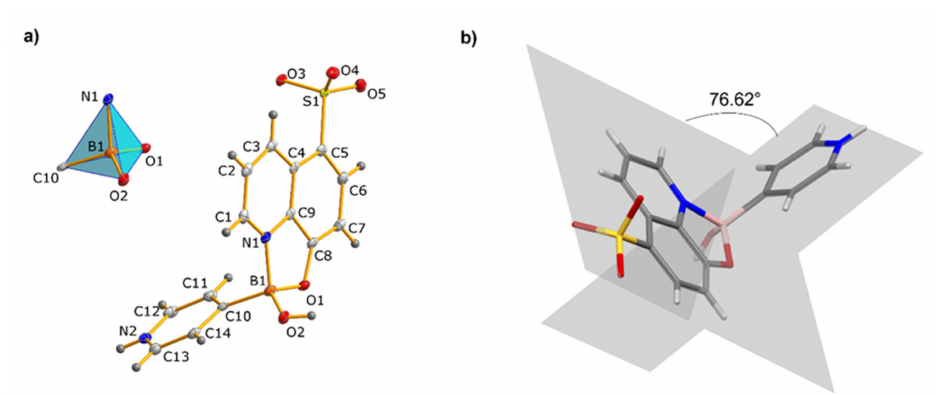
Figure 2. ( a ) Perspective view of the asymmetric unit of compound 2 with atom labeling and ellip- soids drawn at the 50% probability level. Selected bond parameters: B1-N1 = 1.665(3), B1-O1 = 1.516(2), B1-O2 = 1.400(2), B1-C10 = 1.621(3) Å, O1-B1-N1 = 97.69(13), O1-B1-C10 = 110.26(15), O2-B1-O1 = 114.78(16), O2-B1-N1 = 113.14(16), O2-B1-C10 = 112.00(16), C10-B1-N1 = 107.99(14) ◦ . ( b ) Angle between the quinoline and pyridinium rings in 2